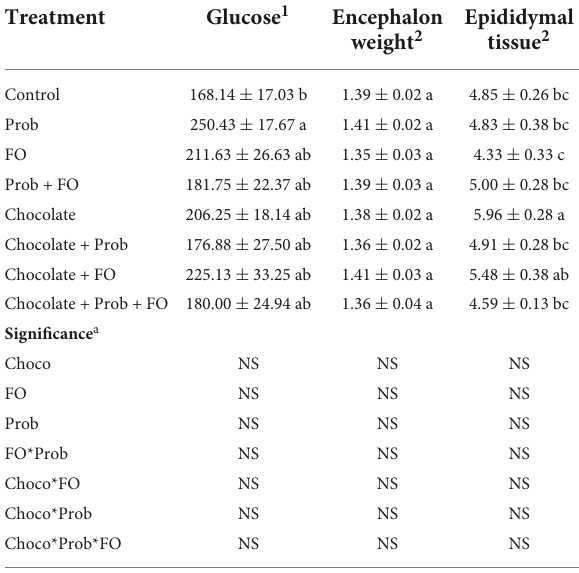
TABLE 2 Effect of treatments in glucose concentration, encephalon, and epididymal weight after Barnes Maze test.